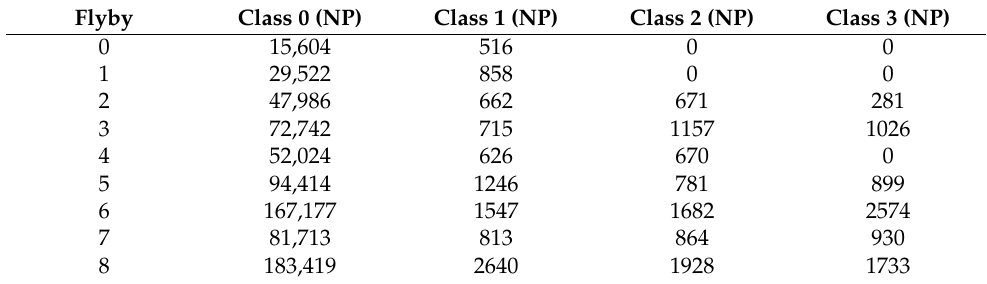
Table 5. Number of pixels (NP) present for each class in 20/9 F-BUMA flight: class 1 corresponds to the orange target data, class 2 to the white target and class 3 to the rope target data. Class 0 was created with all the remaining pixels, containing both land and water data. Flyby Class 0 (NP) Class 1 (NP) Class 2 (NP) Class 3